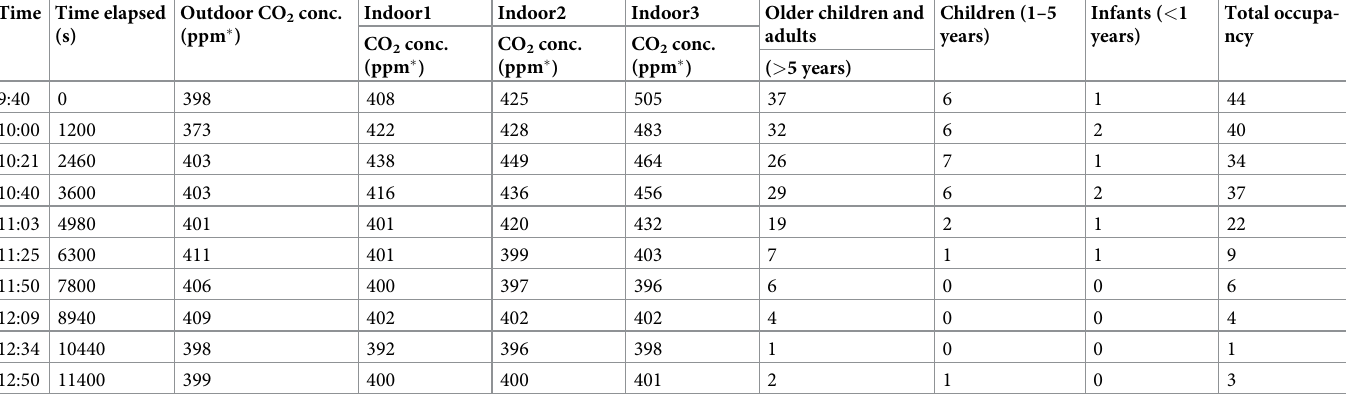
Table 2. Carbon dioxide (CO 2 ) measurements taken immediately outside the room, from three CO 2 meters at central locations within the room, and concurrent headcounts of room occupants. Time Time elapsed Outdoor CO 2 conc. (ppm � ) (s)